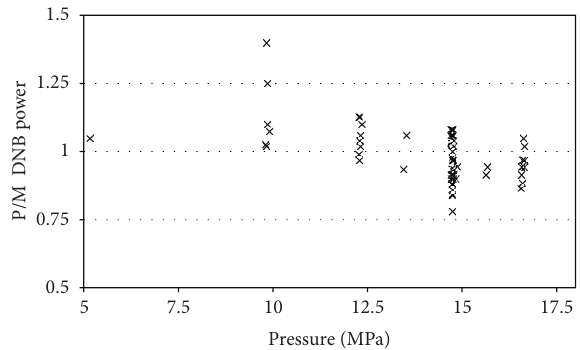
F 10: P/M DNB power versus power for assembly types A0, A2, A3, A4, and A8.